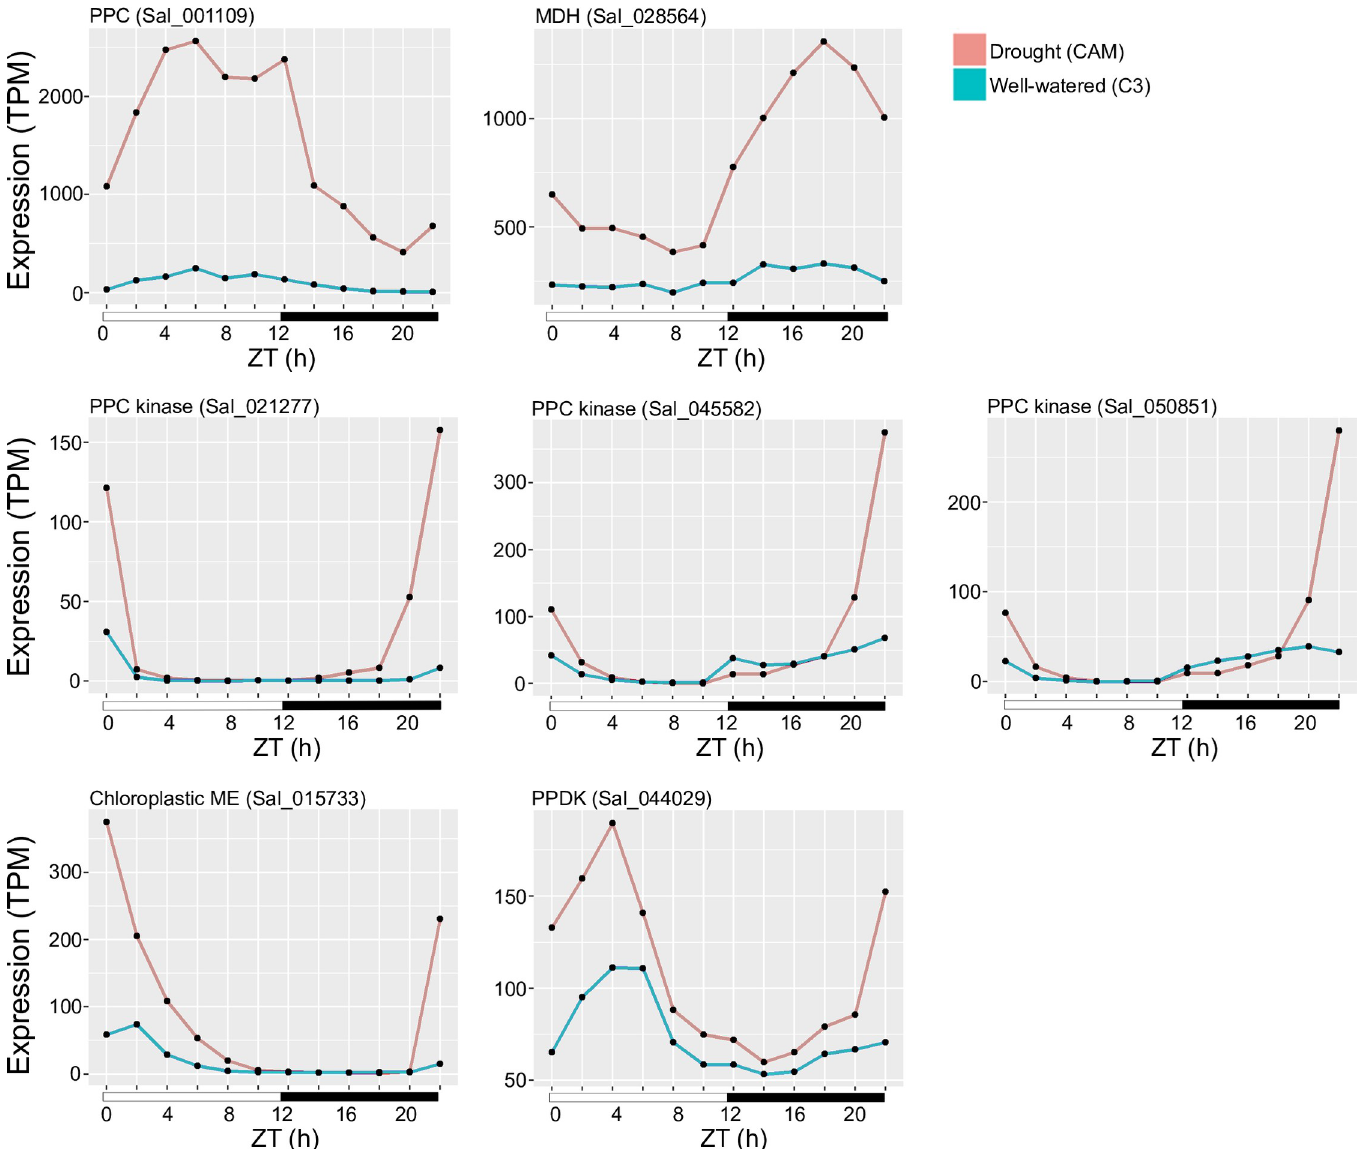
Fig 5. Expression of core CAM pathway genes in the S . album C3 and CAM-cycling timecourses. The expression in transcripts per million (TPM) is plotted for core CAM genes across the 24-hour timecourse in the C3 (blue) and CAM-cycling (red) conditions.